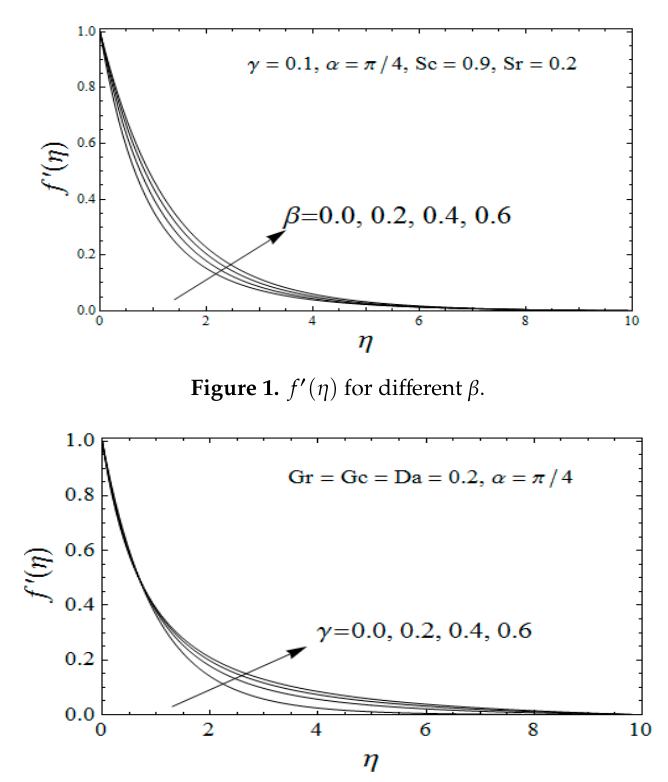
Figure 2 . 𝑓′(𝜂) for different 𝛾. Figure 2. f (cid:48) ( η ) for di ff erent γ